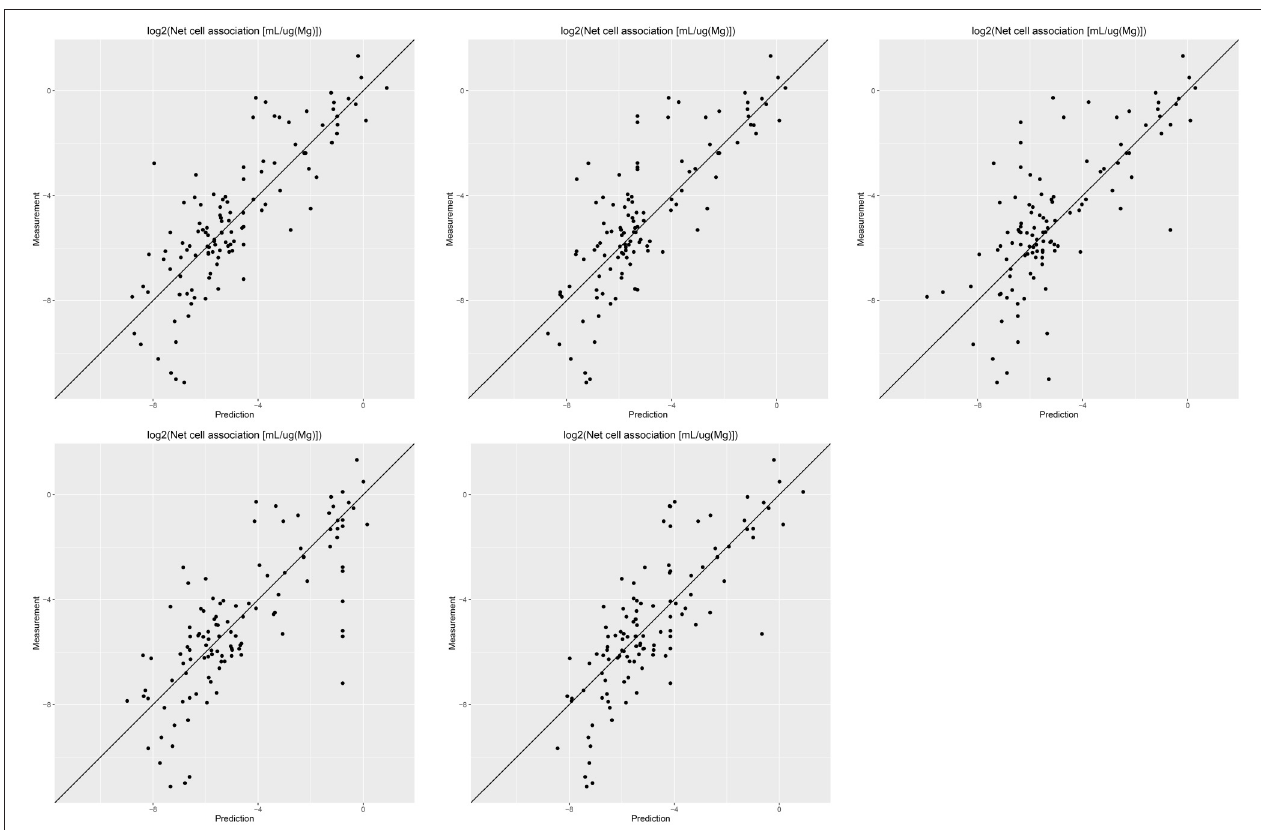
FIGURE 3 | Correlation of predicted vs. measured values for five independent crossvalidations with Proteomics descriptors and local random forest models.